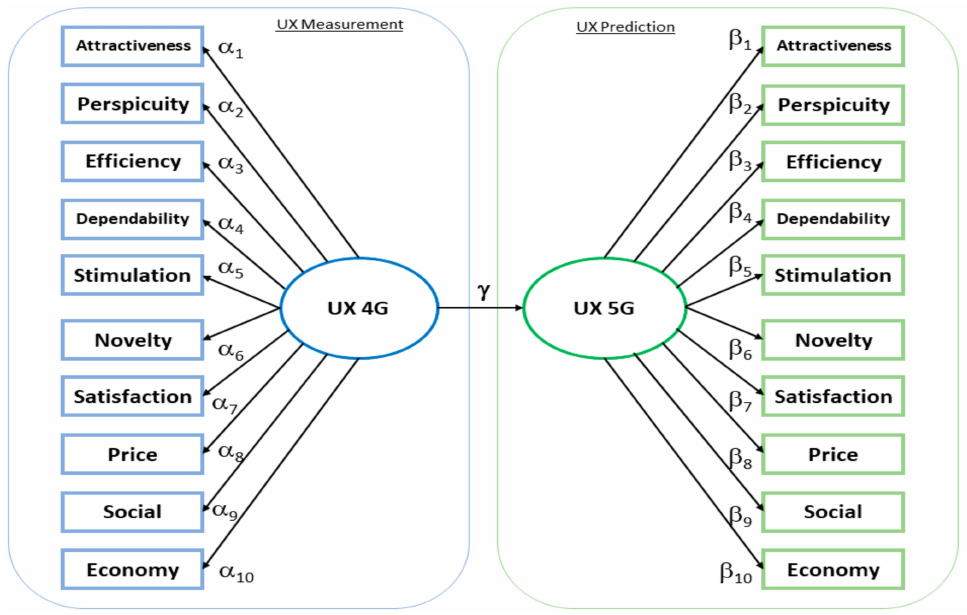
Figure 2. Conceptual